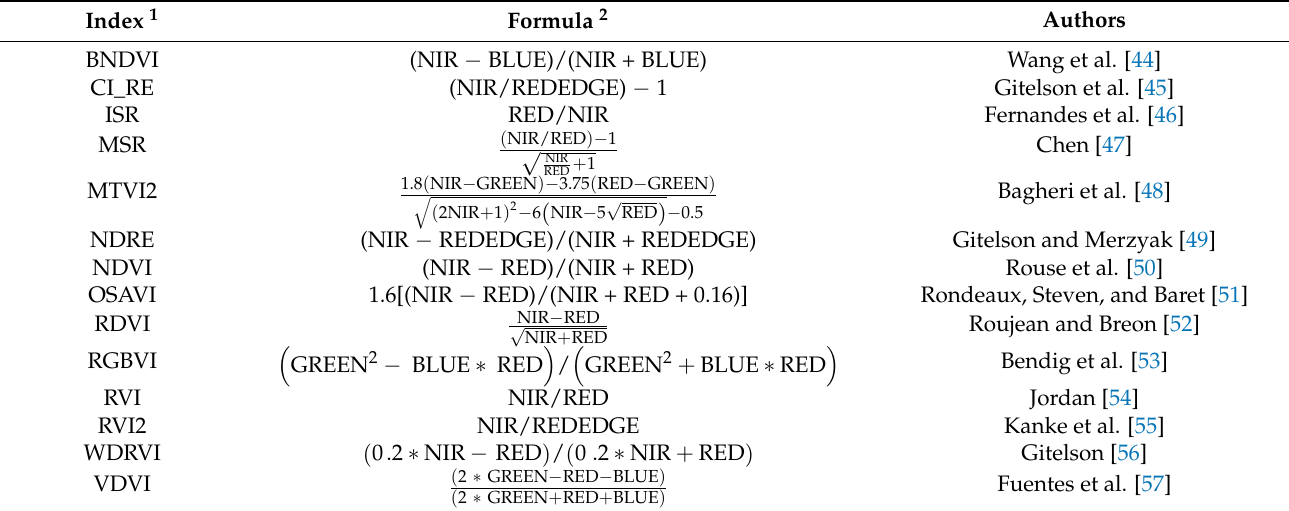
Table 4. Vegetation indices used in the